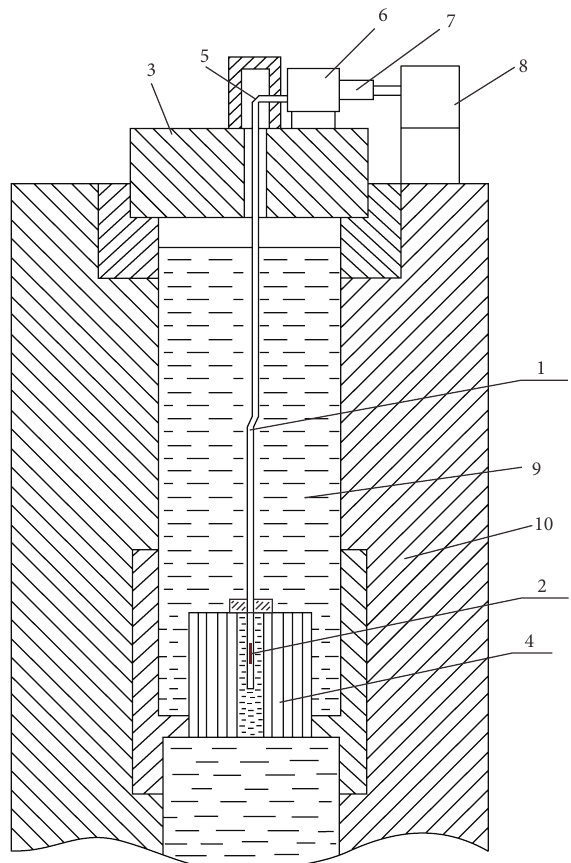
Figure 1: Installation for spectral studies on nuclear reactor. 1— experimental channel, 2—ampoule, 3—cast iron lid of the reactor, 4—the reactor core, 5—rotating mirror, 6—SPM-2 monochromator, 7—photomultiplier, 8—radiometer, 9—unsalted water, and 10— concrete